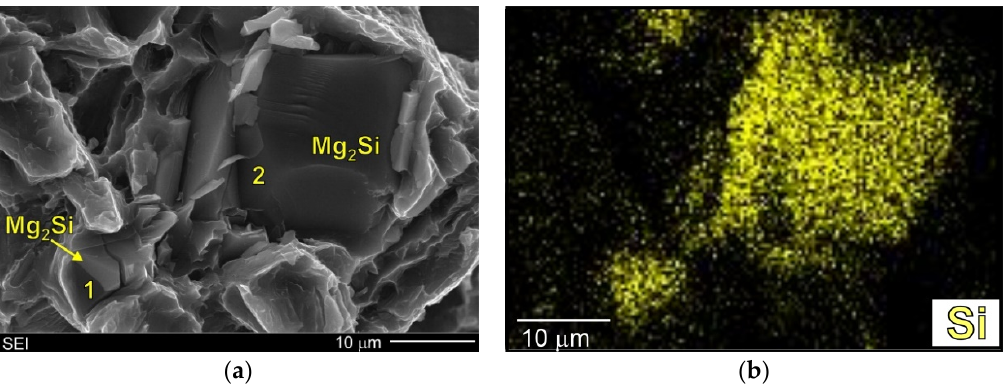
Figure 12. SEM micrographs of Mg/Mg 2 Si–HR composite of fracture surfaces (after uniaxial tensile test) ( a ) with adequate silicon surface distribution (EDX) ( b ).